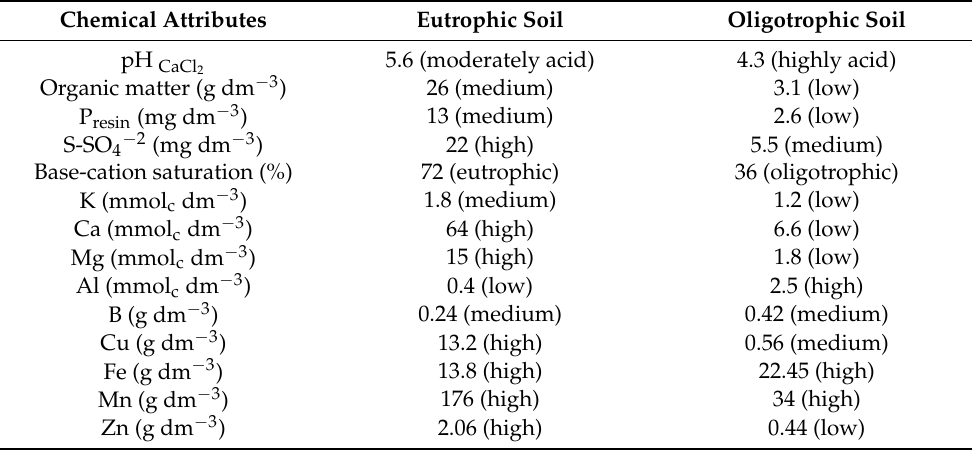
Table 1. Chemical attributes of the studied soils. Adapted from